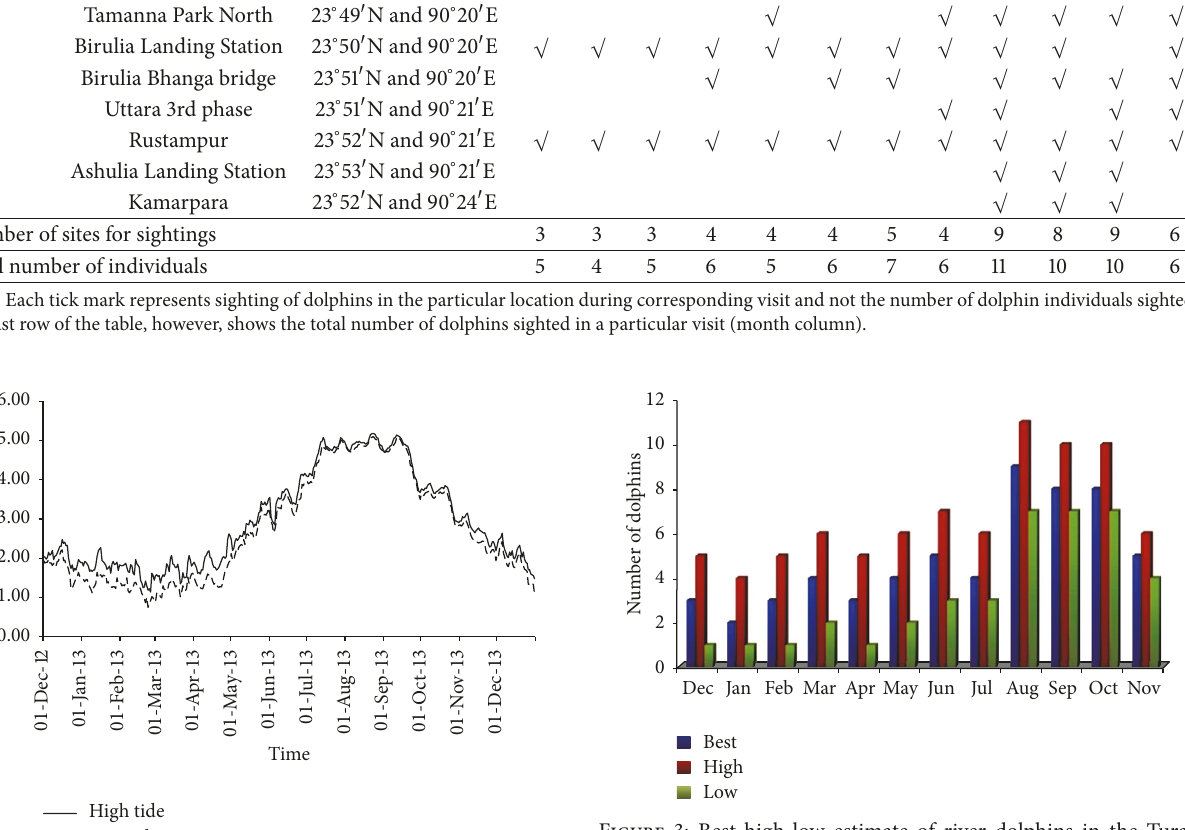
Figure 3: Best-high-low estimate of river dolphins in the Turag